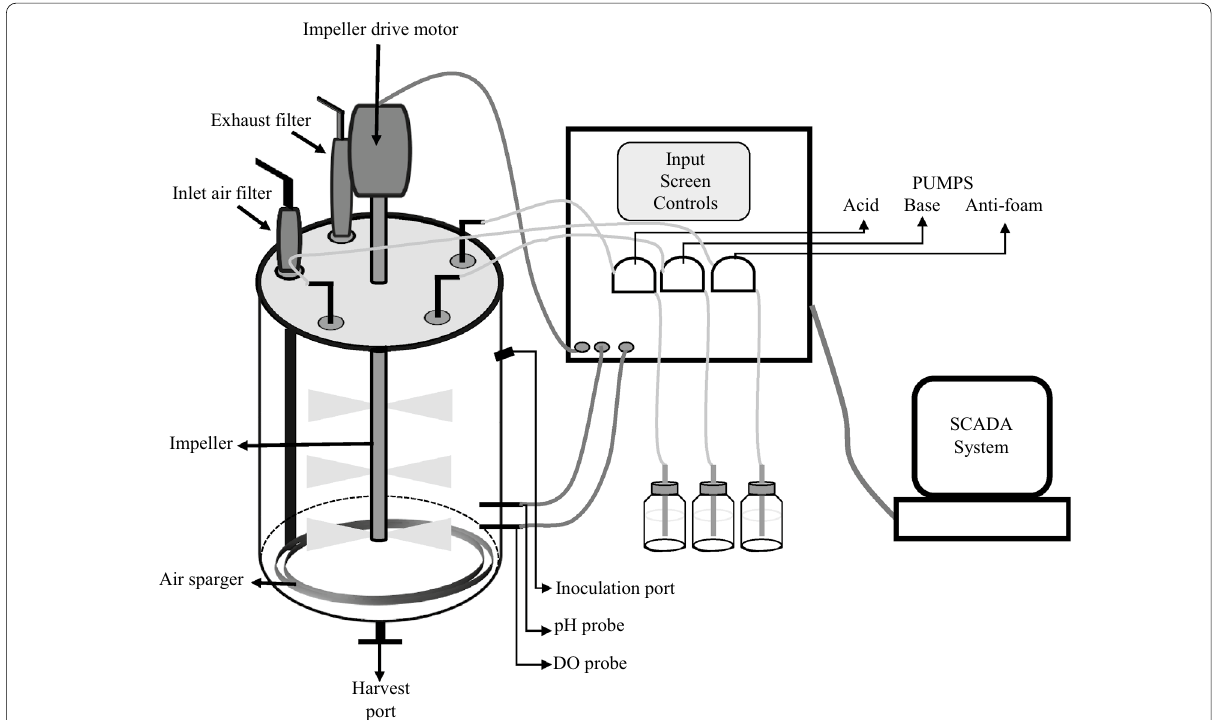
Fig. 2 Schematic of a generalized stainless-steel fermenter of 15–200 L scale, associated controls and